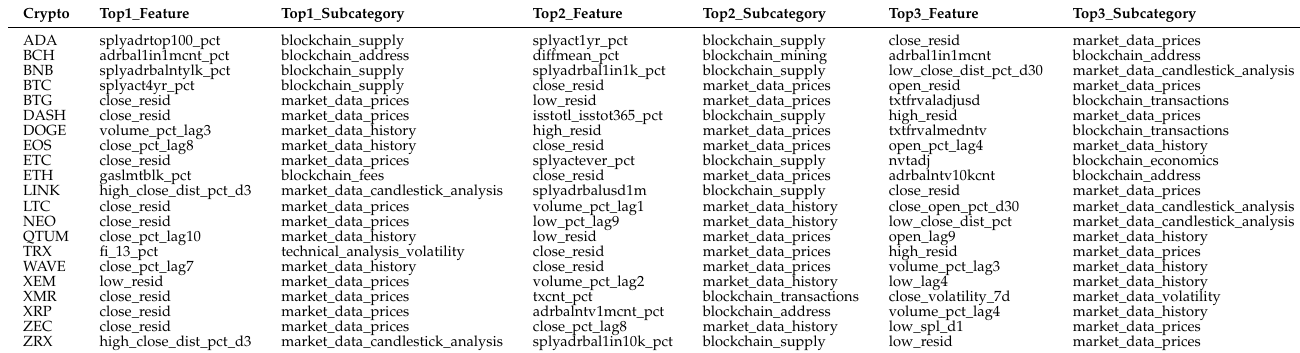
Table 4. Most influential features for class Downtrend.